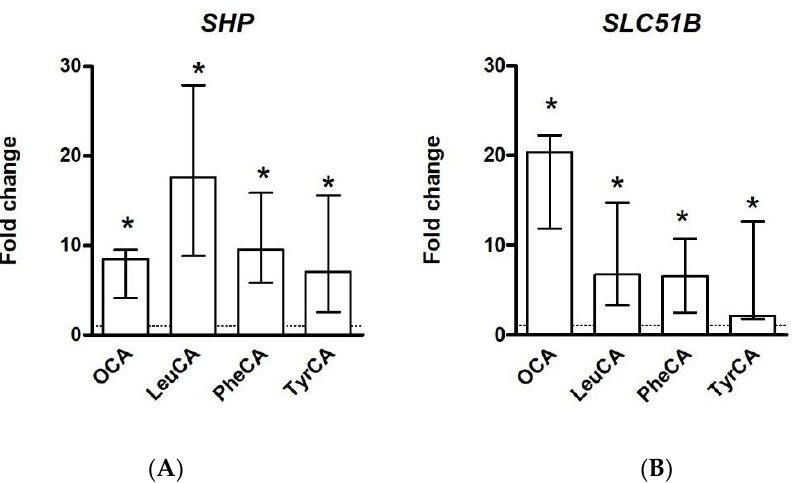
Figure 2. MBSCs induce FXR target gene expression in human HuH7 hepatoma cells. HuH7 cells overexpressing NTCP were grown until ca. 80% confluency. After overnight serum starvation, cells were treated for 6 h with solvent (0.1% DMSO) or the indicated test compounds (OCA: 10 µmol/L, MBSCs: 50 µmol/L). MBSCs were synthesized as described [9]. Gene expression was assessed by RTqPCR and is expressed relative to the control group (solvent-exposed cells, dotted line). MBSCs induce expression of FXR targets short heterodimer protein (SHP) ( A ) and solute carrier family 51B (SLC51B/OSTβ) ( B ). A representative experiment with 4 replicates per condition is depicted. Bars represent median and range (* denotes P < 0.05, Mann – Whitney U test).